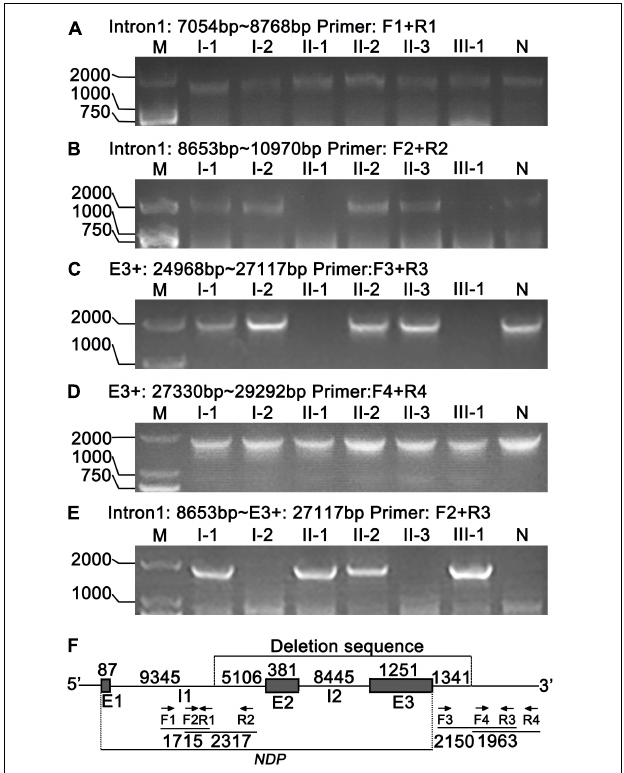
FIGURE 7 | Location and identification of NDP deletion by PCR. (A,B) 5 (cid:48) end location of NDP deletion. Primer pairs: F1, R1 and F2, R2, respectively. (C,D) 3 (cid:48) end location of NDP deletion. Primer pairs: F3, R3 and F4, R4, respectively. (E) Identification of NDP deletion. Primer pairs: F2, R3. (F) Schematic of NDP deletion. E1, E2, and E3: exons 1–3 of NDP ; I1, I2: introns 1–2 of NDP ; arrows: primers; numbers: base count of each